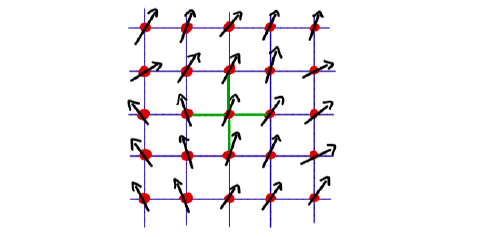
Figure 12: Spins on a lattice. The nearest-neighbor links around the central spin are indicated in